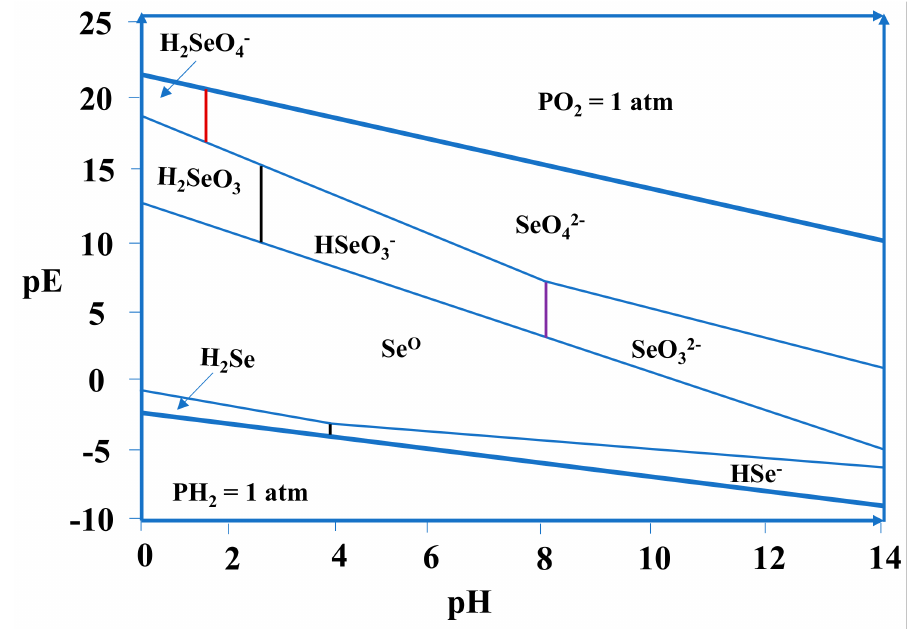
Figure 2. pE-pH phase diagram of selenium speciation adapted from